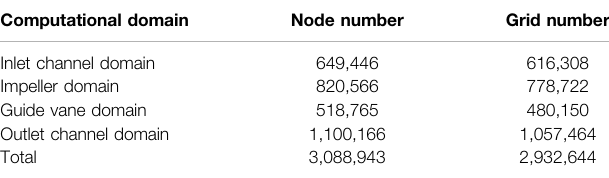
TABLE 1 | Fluid domain mesh nodes and number of meshes.